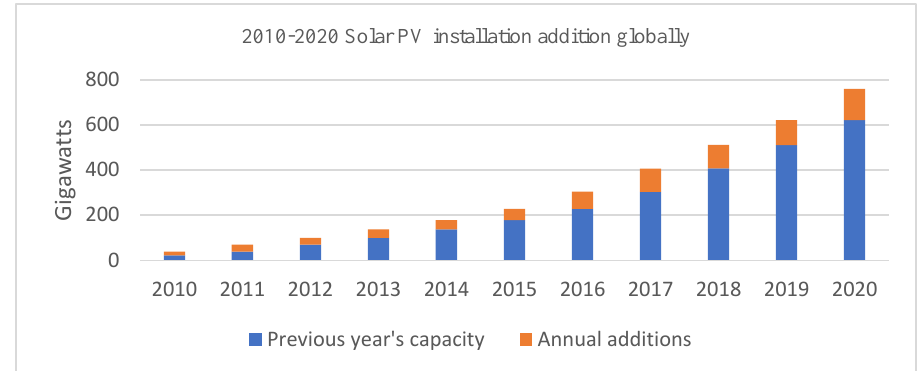
Figure 5. Solar PV global capacity and Annual Additions [55].